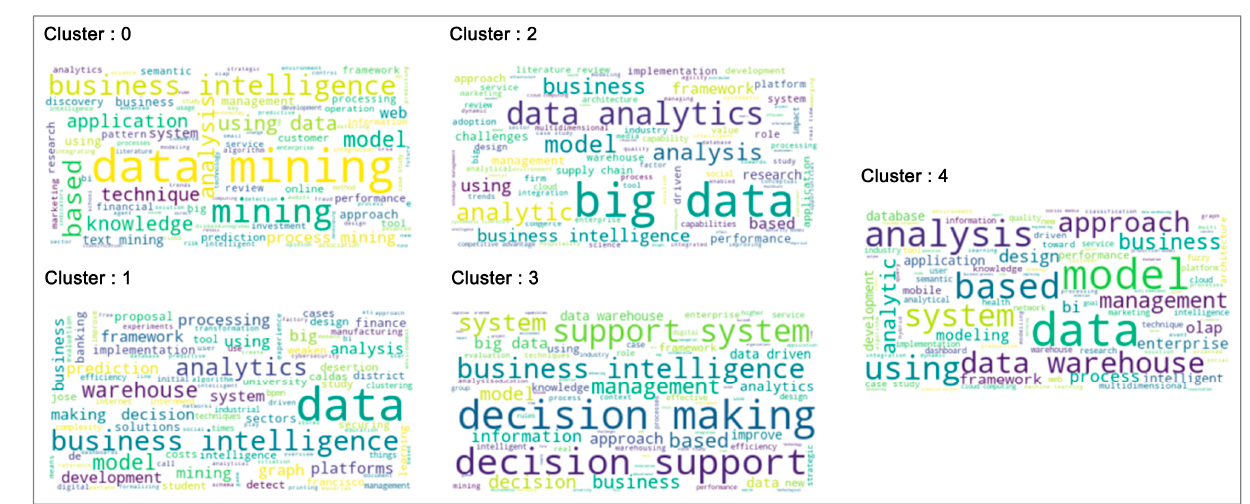
Figure 18. Predominant word cloud by discovered article cluster. The results of the main clusters, after the application of k-means clustering (stage 2), with respect to scientific production over the last twenty years, showed a group that stands out: clusters 4, 1 and 2 can be located within topics 5, 7, 12 and 16. It shows the same behavioral pattern of scientific interest focused on empirical industrial domains, such as unstructured big-data processing with orientations towards business, market and customer data analytics (Figure